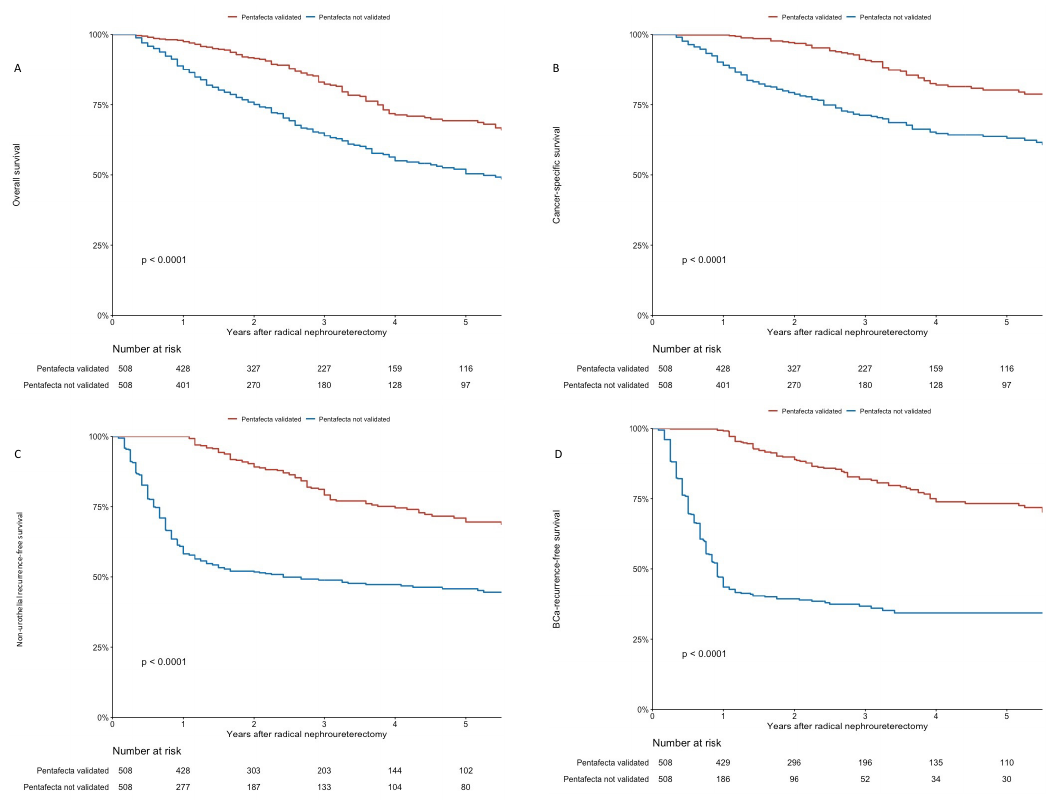
Figure 2. ( A – D ): Oncologic outcomes of 1016 patients treated with RNU for high-risk UTUC after propensity-score matching. Kaplan-Meier curves visualizing overall ( A ), cancer-specific ( B ), non- urothelial recurrence-free ( C ), and bladder-cancer recurrence-free survival ( D